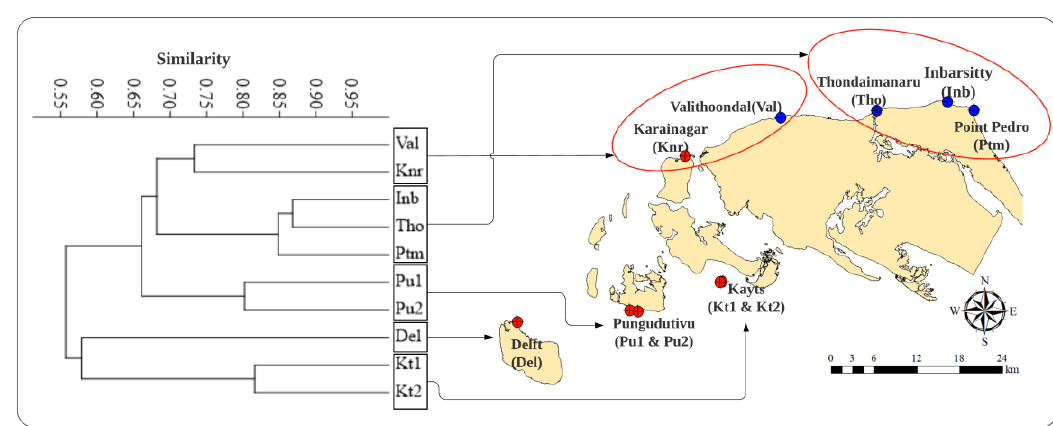
Figure 4. Bray–Curtis Cluster analysis based on differences in the benthic cover on the reefs of the Jaffna Peninsula, together with a map showing the locations of the sites. (Abbreviations as shown on the